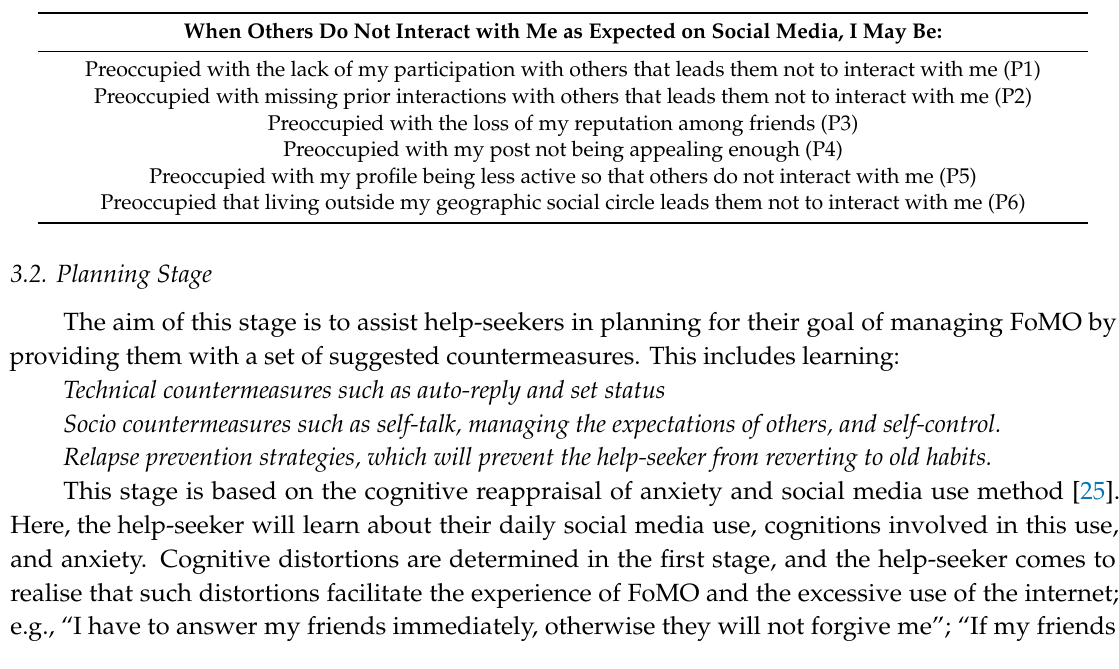
Table 3. Self-rating (Booklet 1 in the Supplementary